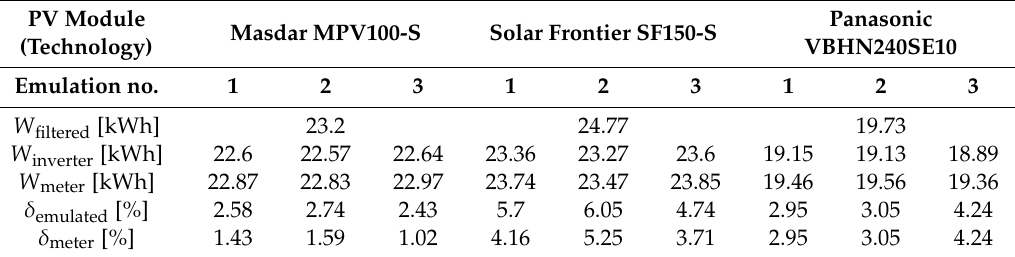
Table 7. Results of fast PV power emulation of the 6 kW PV plant for 1 May 2018.